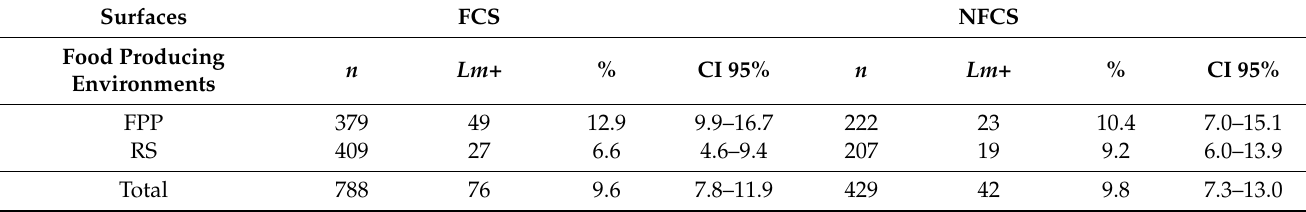
Table 1. Results of tested surfaces based on the food environment typology.